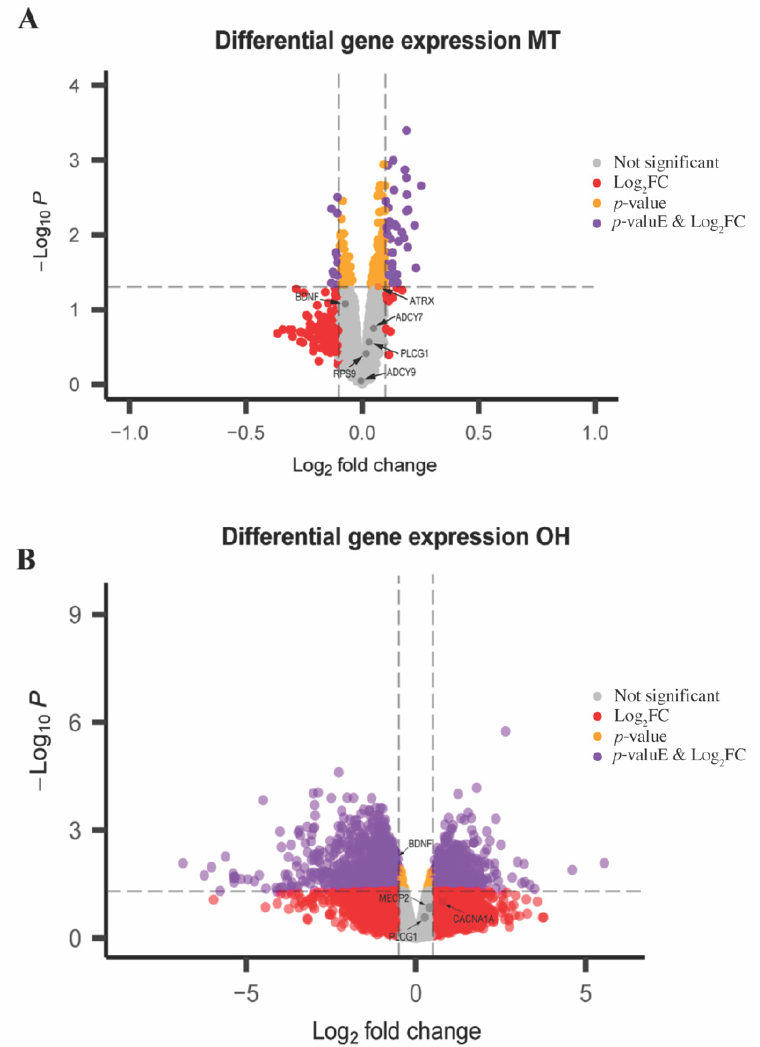
Figure 8 . Expression of hub genes from skyblue module in MT and OH datasets. ( A ) Volcano plot of differential gene expression profiles in the MT data highlighting hub genes with significant changes. ATRX , BDNF , ADCY7 , PLCG1 , RPS9 and ADCY9 are depicted. ( B ) Volcano plot of differentially expressed genes in the OH dataset, highlighting the hub genes BDNF , CACNA1A , MECP2 and PLCG1 . Genes with significant changes in logFC ( p < 0.05) are denoted by purple points. Genes with no significant changes in expression are represented by grey points.